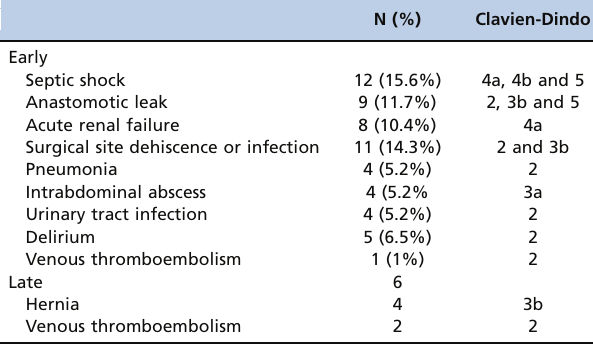
Figure 1 - Distribution of clinical presentations according to TNM staging (AJCC) in the studied population. Table 2 - Postoperative complications (Clavien-Dindo 1-5) of 44 patients